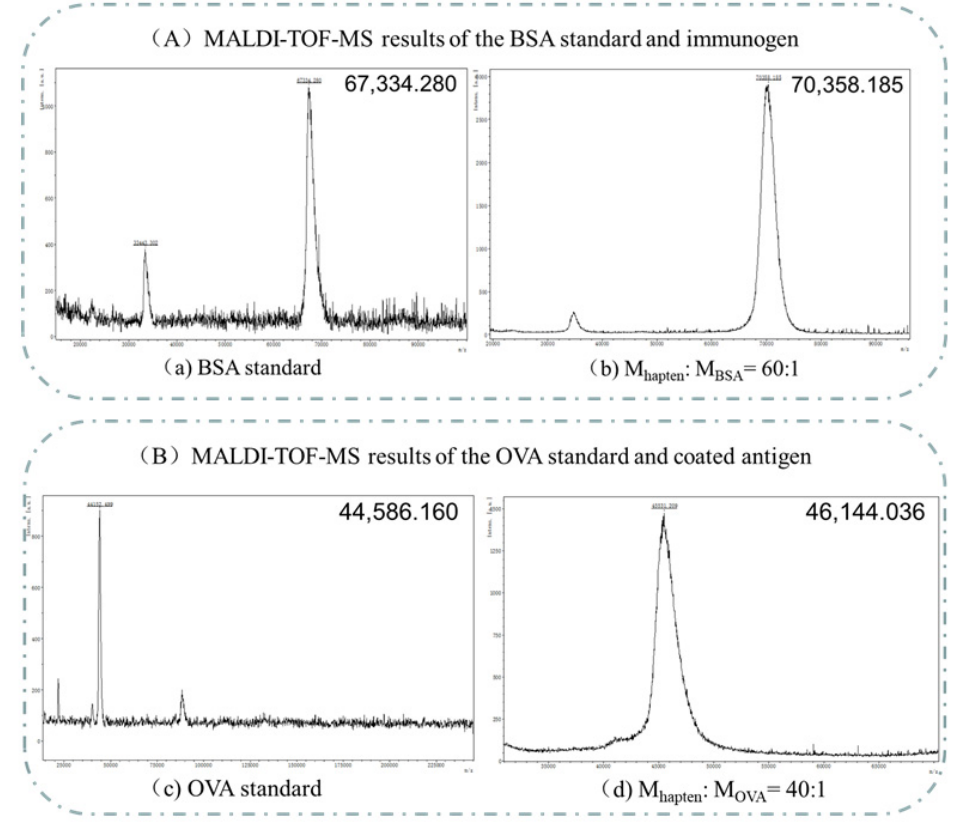
Figure 3. MALDI-TOF-MS results of the immunogen and coating.